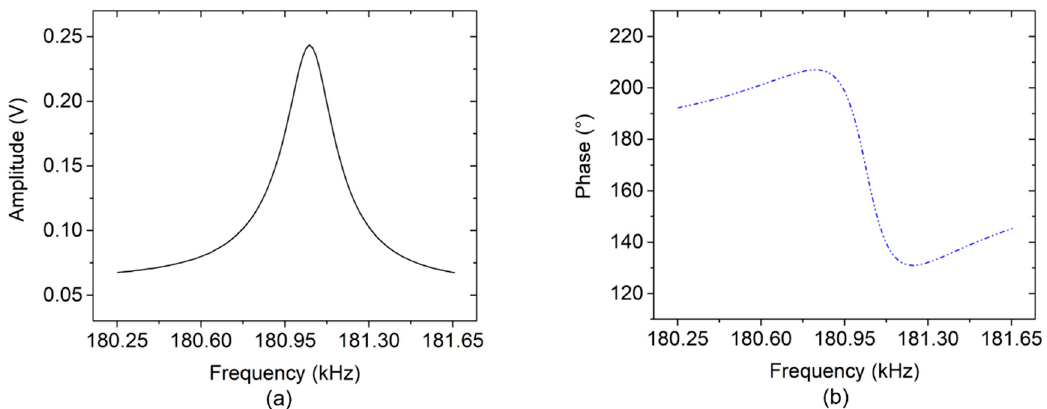
Figure 10. Measured ( a ) amplitude and ( b ) phase responses of the electro-thermal piezoresistive cantilever including reference subtraction.